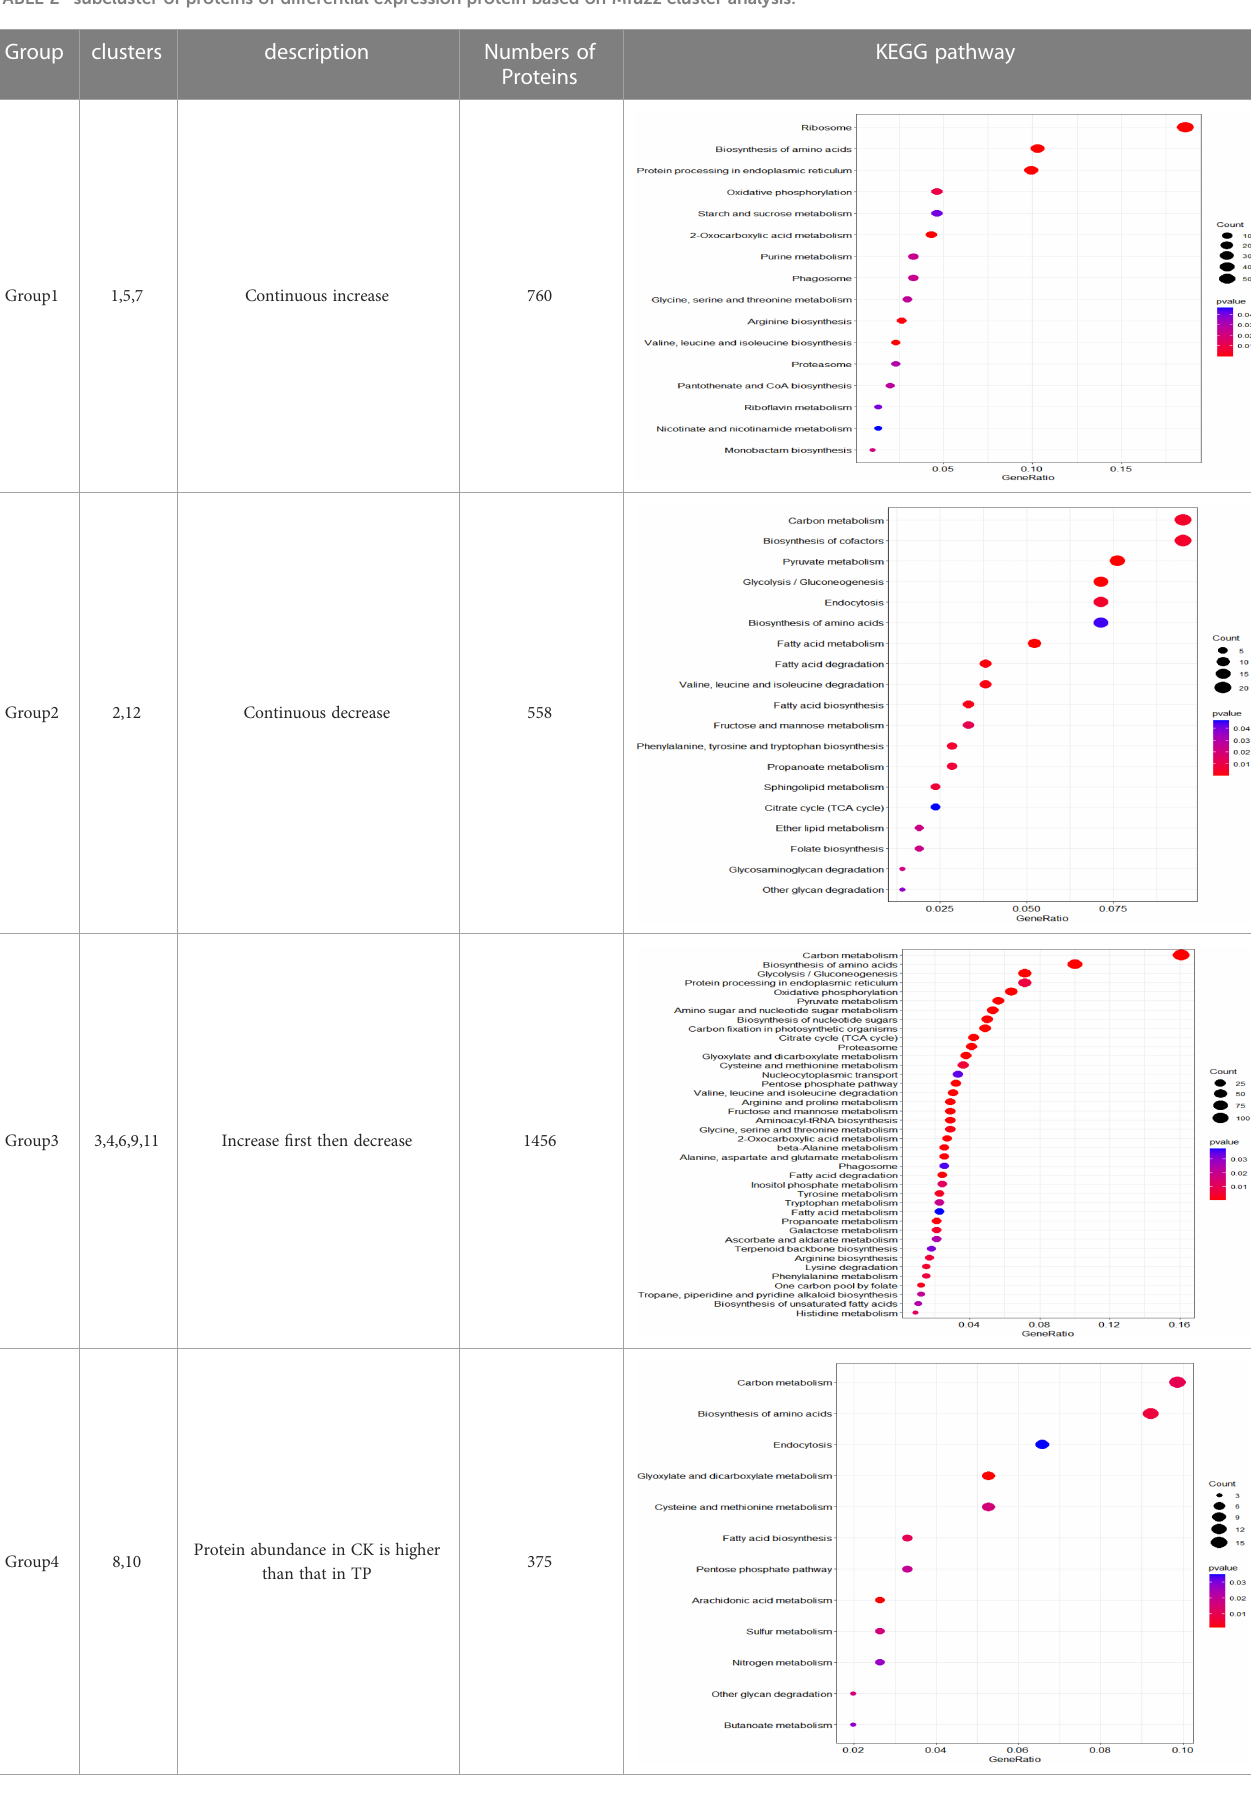
TABLE 2 subcluster of proteins of differential expression protein based on Mfuzz cluster